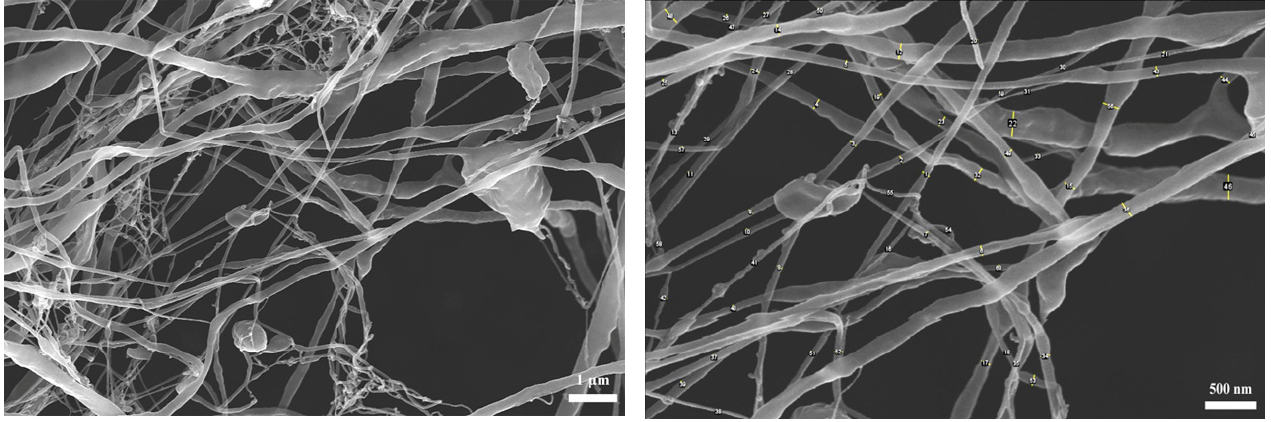
Figure 10. SEM of